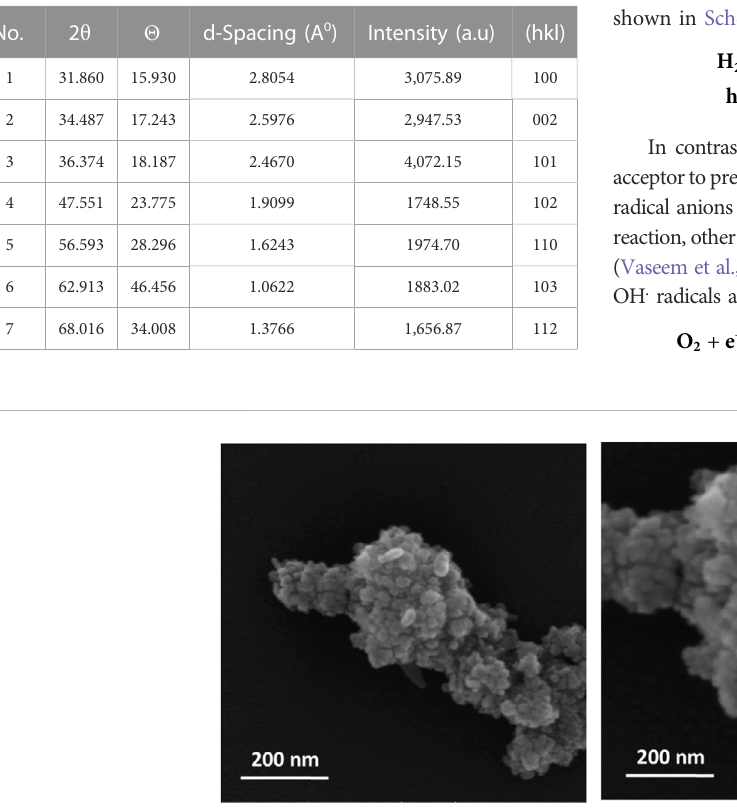
TABLE 1 XRD analysis of ZnO NPs.